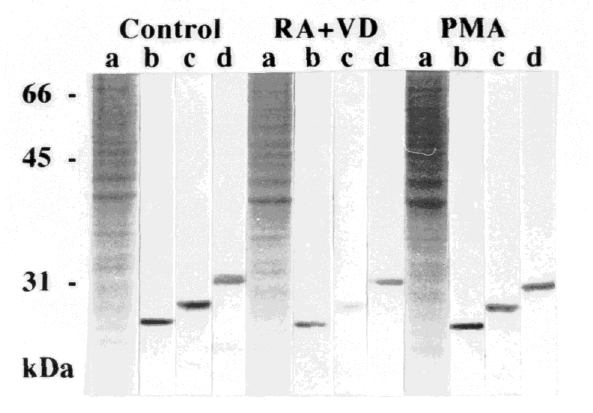
Fig. 2. Western blot detection of proteasomal proteins of control cells and cells induced to differentiate during 72 h by 100 nM RA + 100 nM VD or 160 nM PMA. Whole protein extracts were prepared from an equal number of cells (250,000) and separated by SDS-PAGE (lanes a), blotted onto nitrocellulose and analyzed with the p-mAbs anti-p25K (lanes b), anti-p27K (lanes c) and anti-p30/33K (lanes d). Anti-p25K (7A11) recognize a protein of 25 kDa which was identified as the C3 alpha subunit, anti-p27K (IB5) react with a 27 kDa protein identified as the IOTA alpha subunit and anti-p30/33K (62A32) recognize a 33 kDa protein known as the C2 alpha subunit. Irrelevant was included in each series using normal mouse immunoglobulins in place of the monoclonal